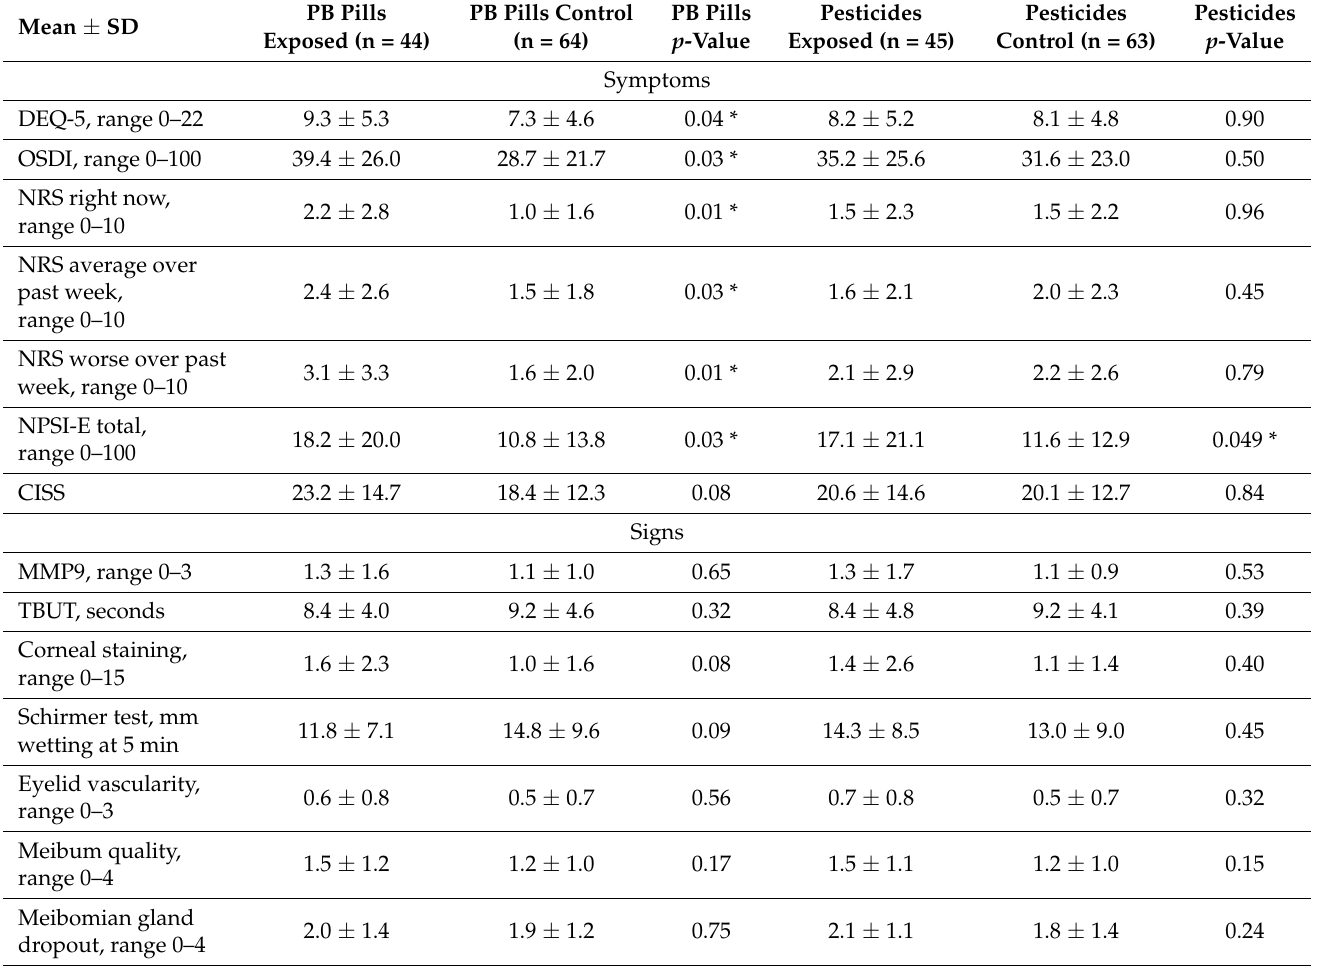
Table 2. Dry eye symptoms and signs in individual groups by exposure